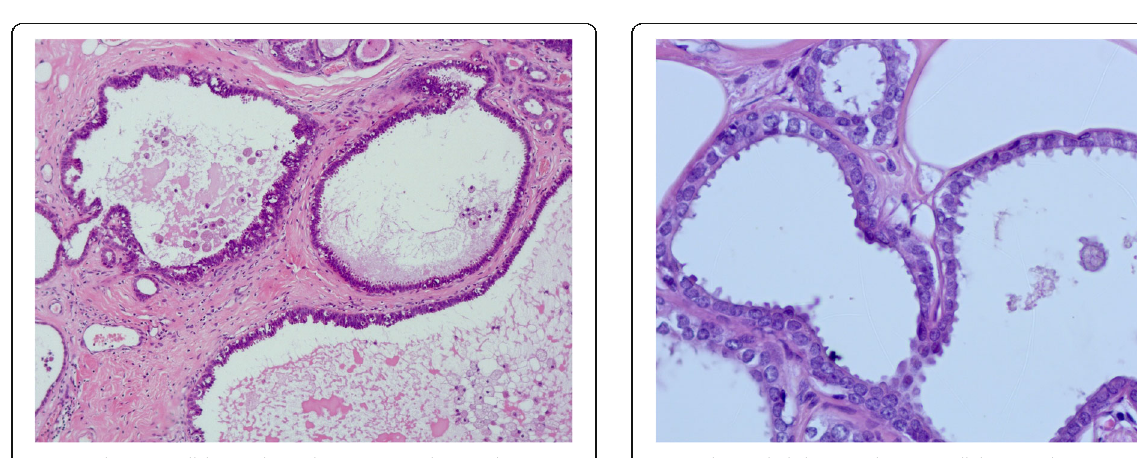
Fig. 5 Flat epithelial atypia showing cellular crowding, coarse calcifications and micropapillary